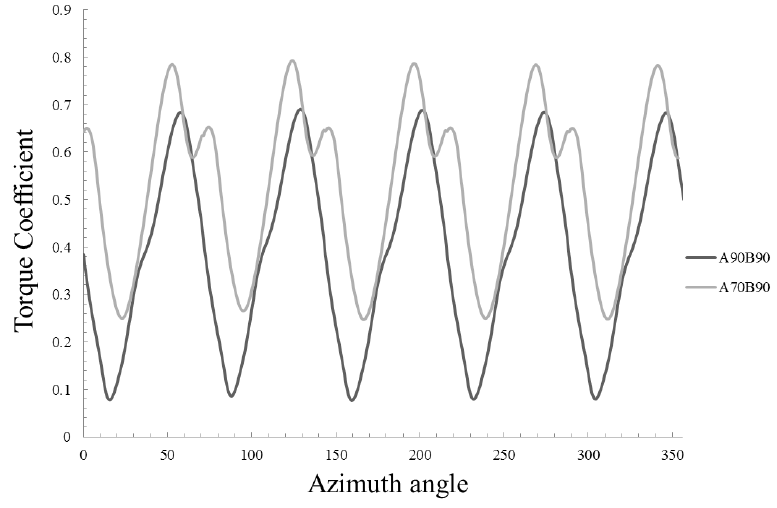
Figure 15. Total torque coefficient of five blades.